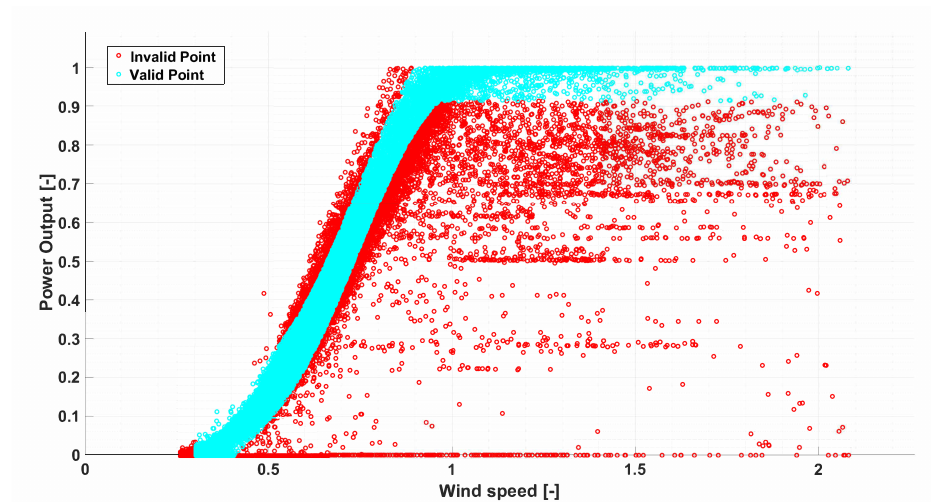
Figure 3. Partitioning of data between Valid and Invalid